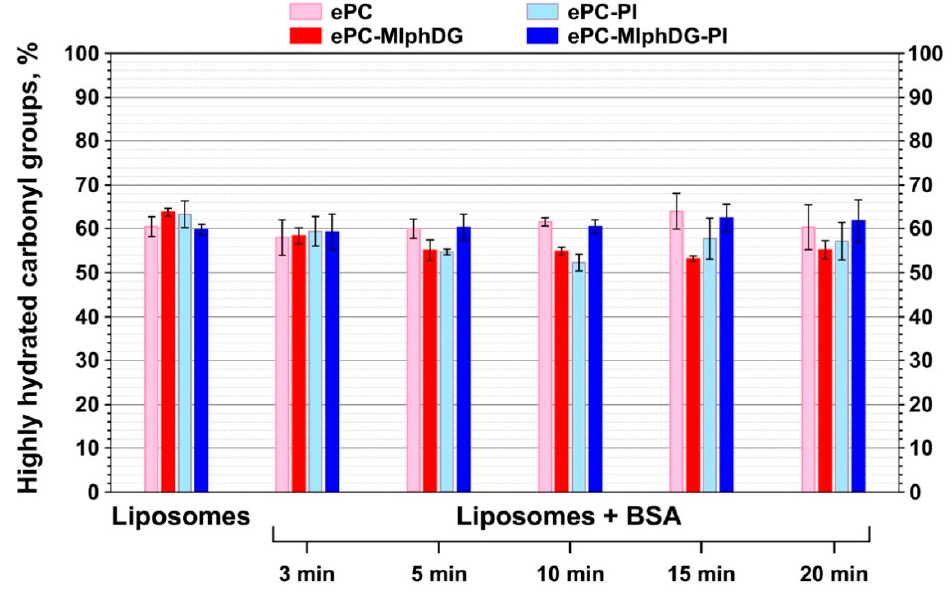
Figure 4. Changes in the percent of highly hydrated carbonyl groups for liposomes of different compositions prior to and upon their incubation with BSA. Mean values ± SE for two independent experiments are presented.